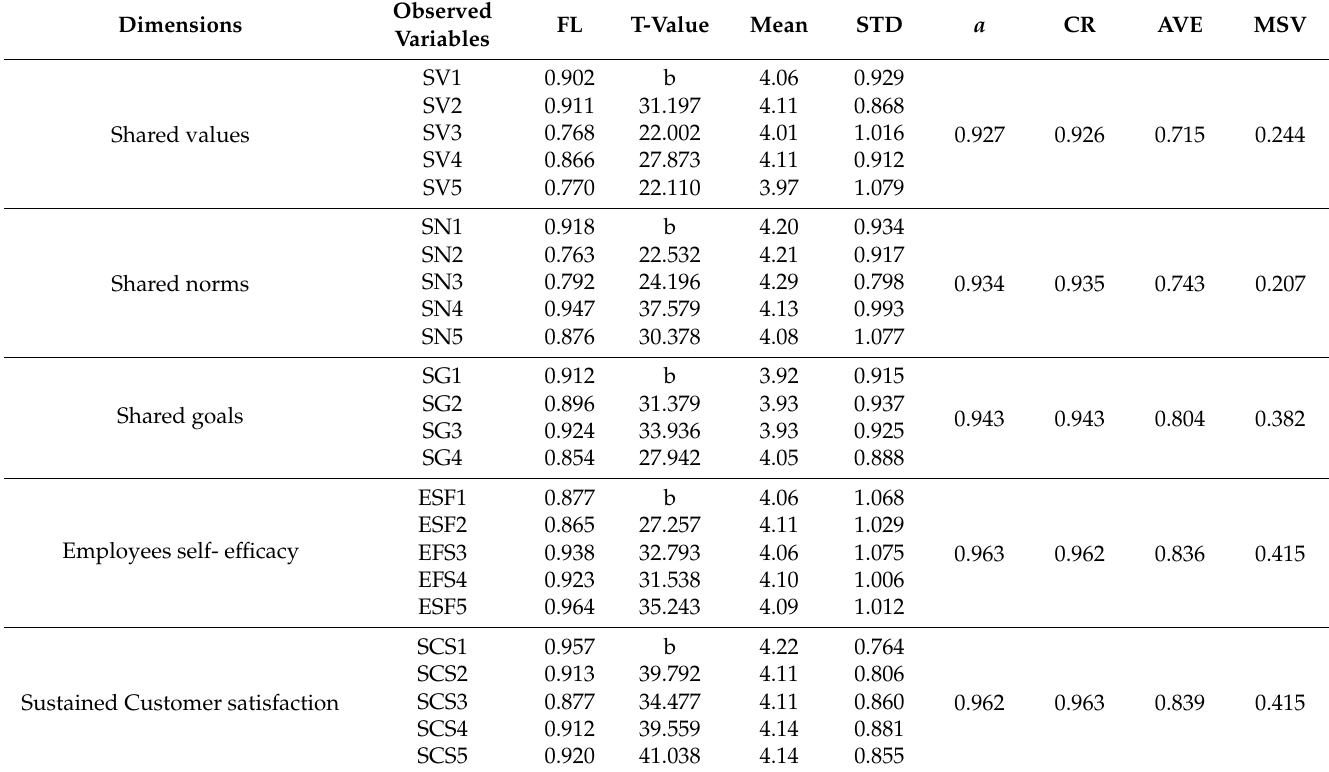
Table 2. Measurement CFA model